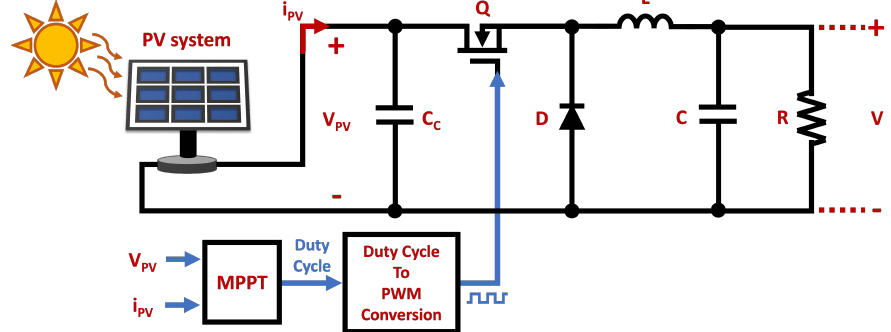
Figure 13. Experimental case study buck converter topology for the validation